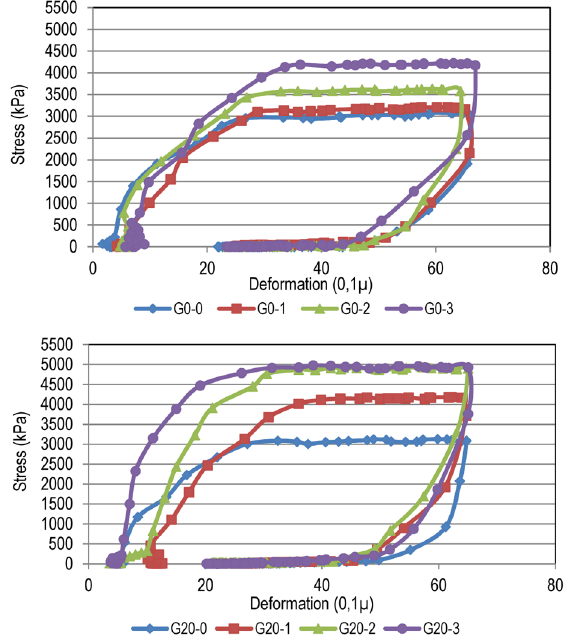
Fig. 9. The load repetition number-deformation relation of the mixtures with aging